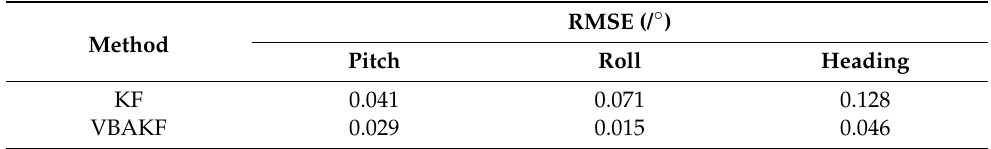
Table 3. The RMSE result of the three-dimensional attitude estimation errors when the measured noise covariance is a random quantity with periodic sinusoidal characteristics.